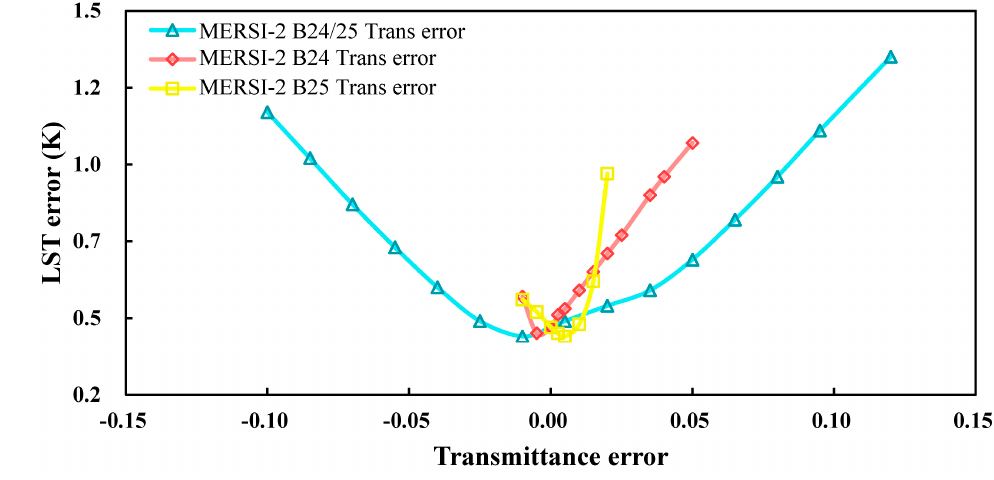
Figure 17. LST error caused by transmittance error.